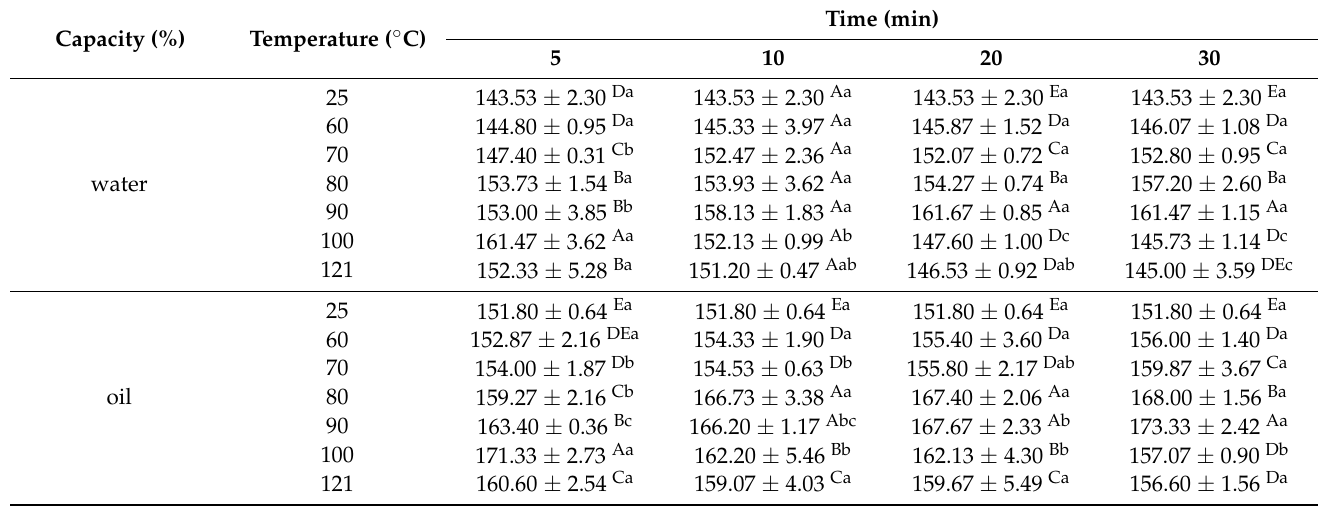
Table 2. Effects of different hydrothermal treatment conditions on the water–holding capacity and oil–holding capacity, %. A–E indicates the significant differences between different temperatures and a–c indicates the significant differences between different times ( p < 0.05).